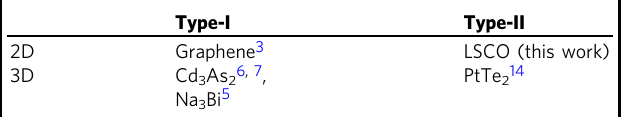
Table 1 Classi fi cation of Dirac